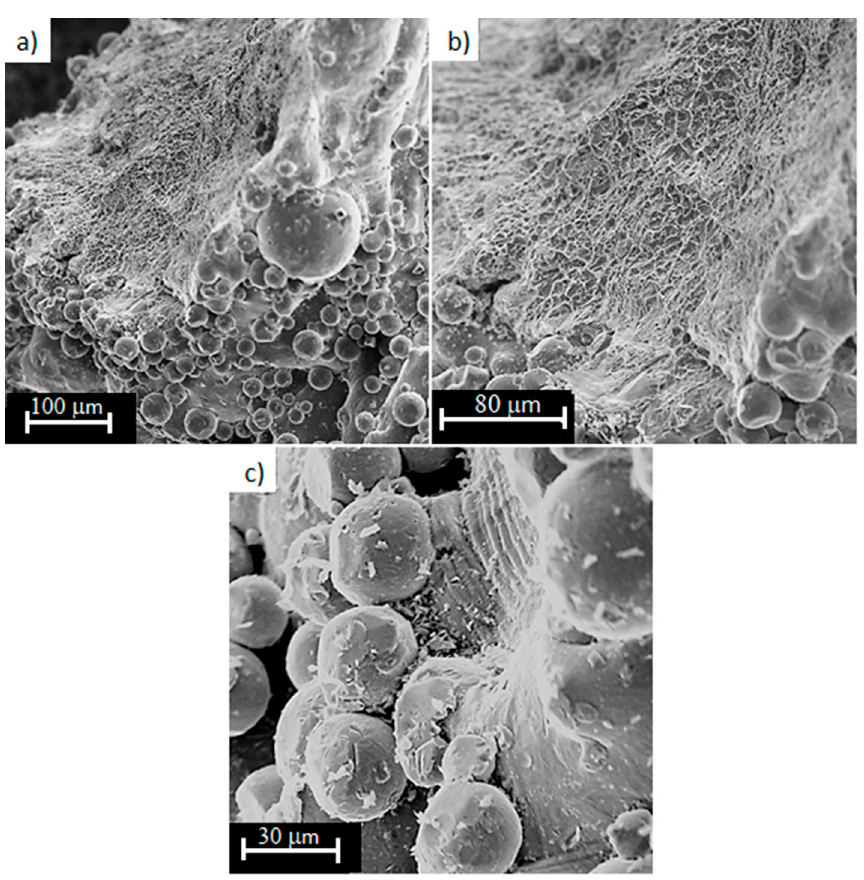
Figure 12. Fracture surfaces of Ti6Al4V titanium alloy with 50% porosity, subjected to a monotonic tensile test (magnification: ( a ) 500 × ; ( b ) 1000 × ; ( c ) 2000 × ). Samples of Ti6Al4V titanium alloy with near-zero porosity were also observed (Figure